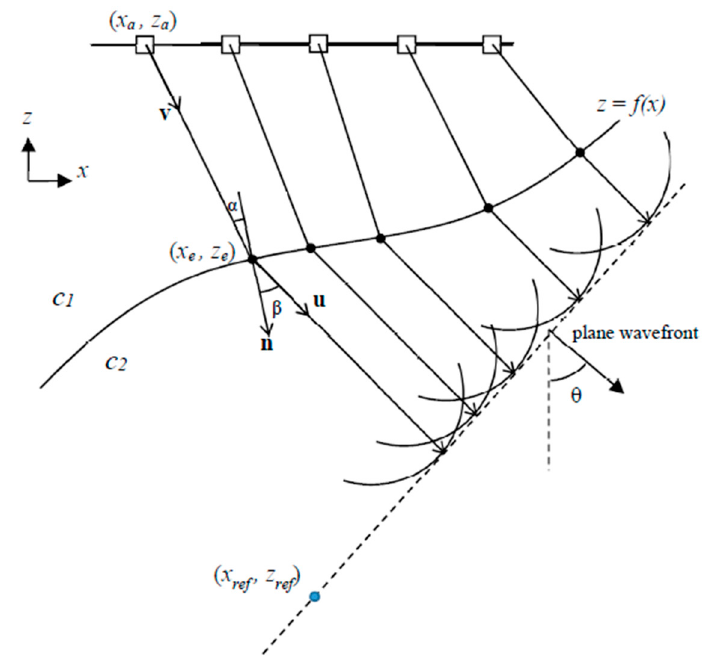
Figure 1. Schematic representation of the geometry for delay law calculation.